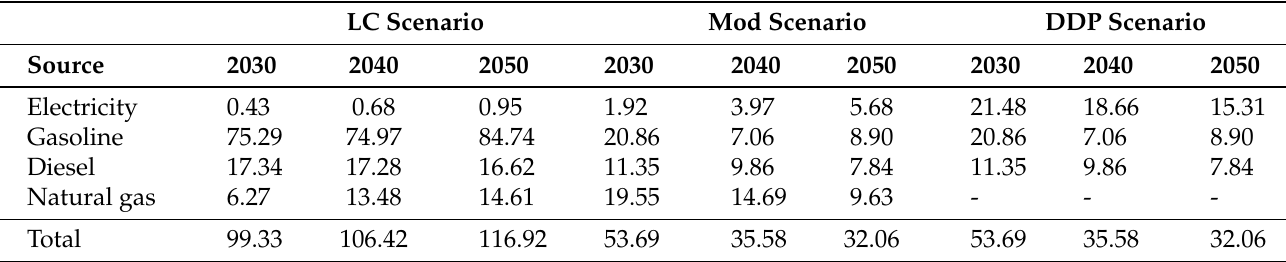
Table 6. Passengers land transport demand in PJ.